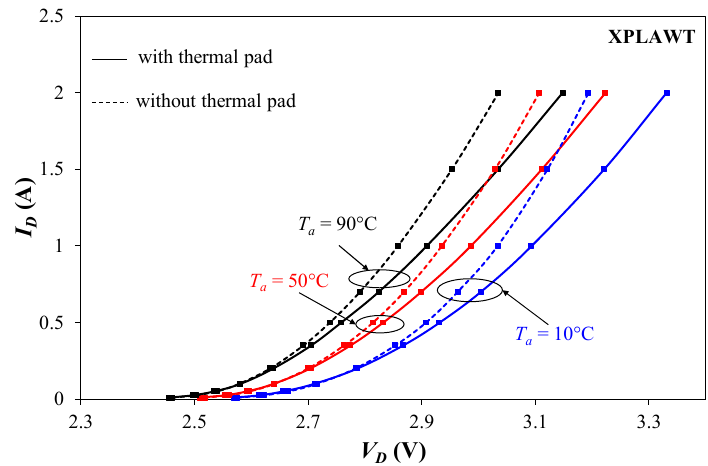
Figure 4. Measured DC I-V characteristics of the XPLAWT diodes at selected values of cold plate temperature.